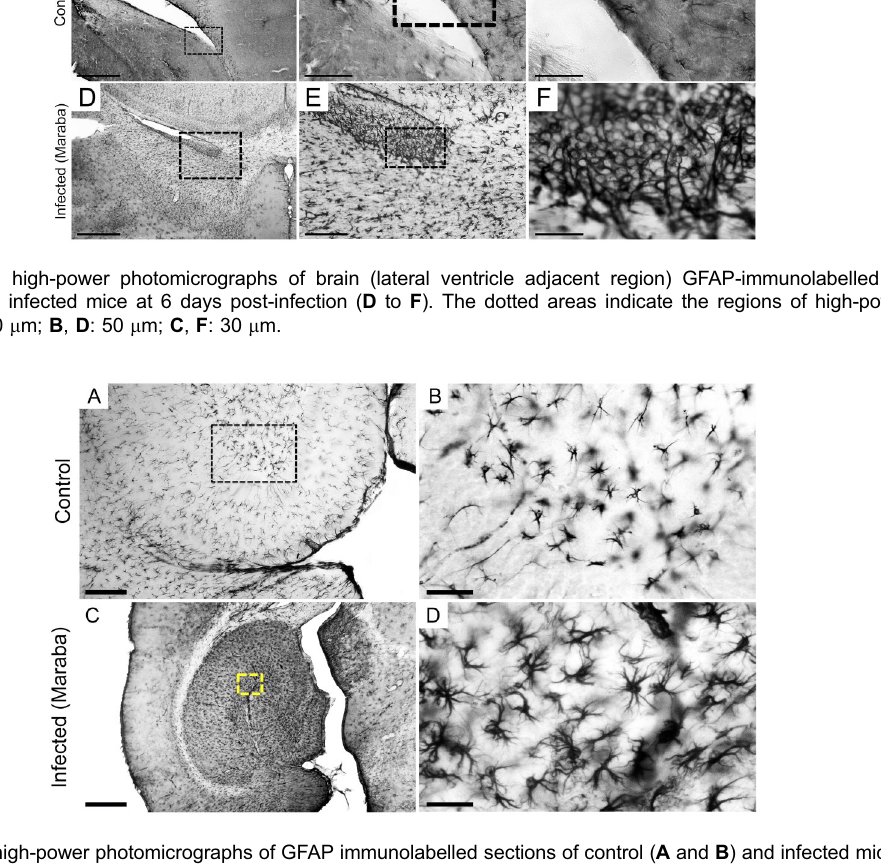
Figure 6. Low- and high-power photomicrographs of GFAP immunolabelled sections of control ( A and B ) and infected mice ( C and D ) at 6 days post-infection. The dotted areas indicate the regions of high-power images. Scale bars A , C : 650 m m; B , D : 30 m